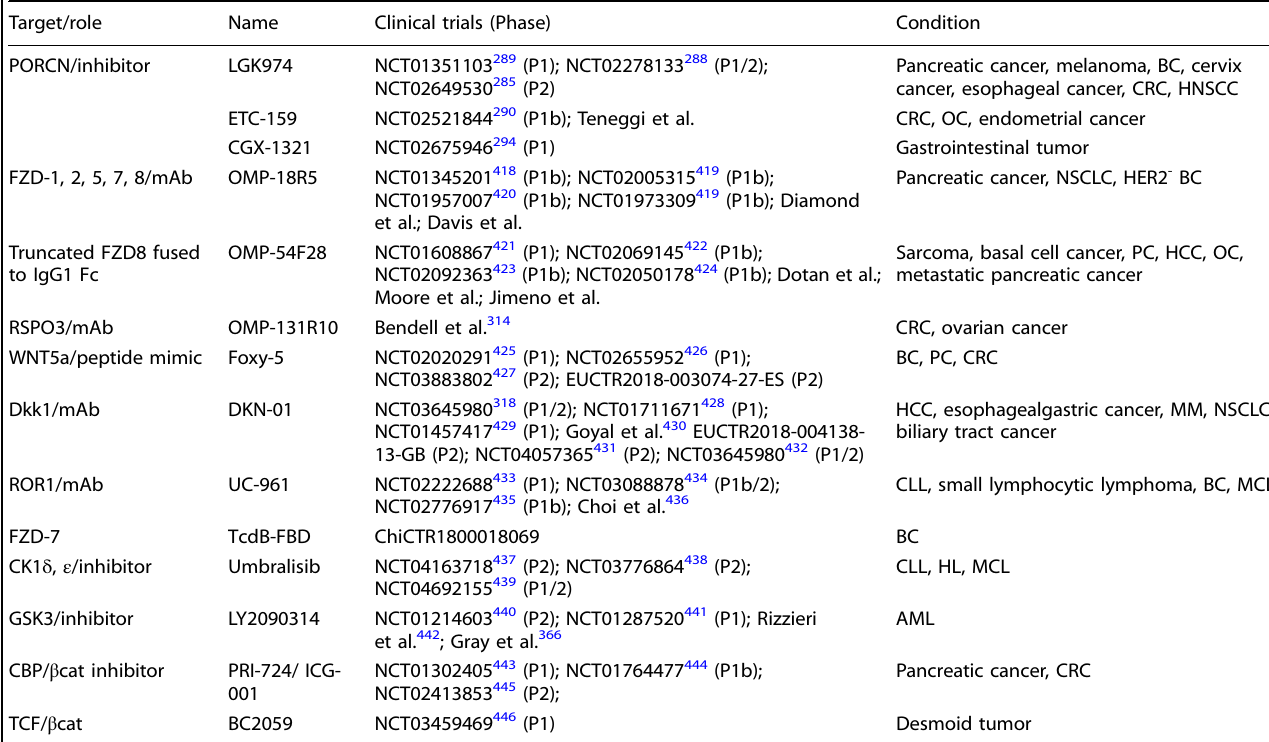
Table 2. The summary of clinical trials estimating the agents targeting canonical Wnt signaling in